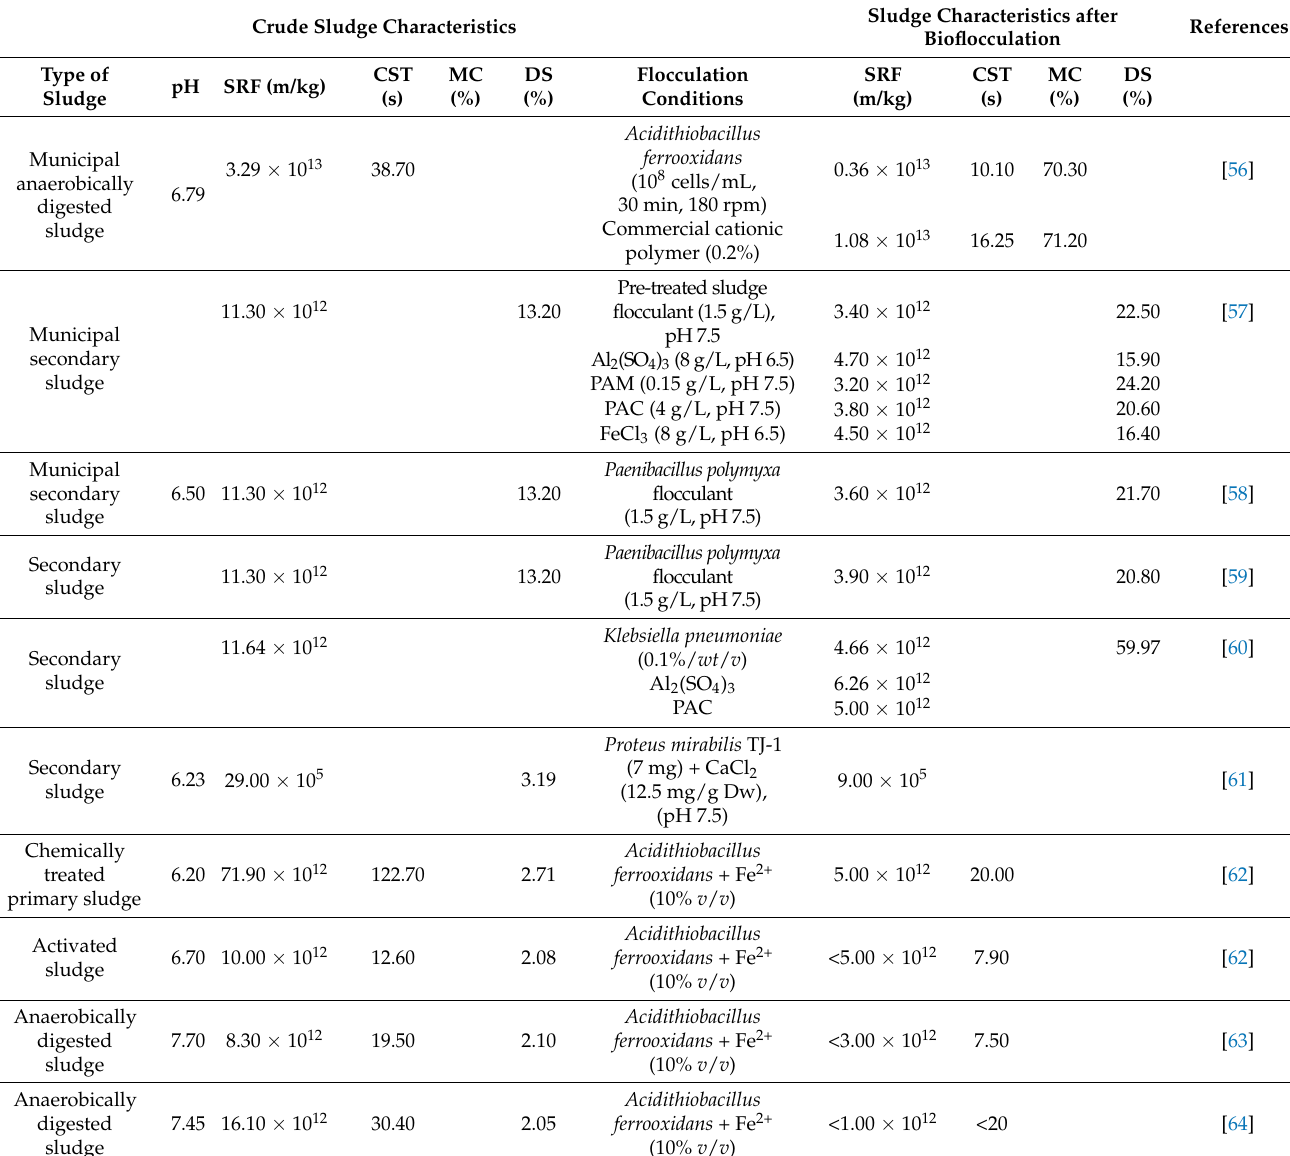
Figure 1. General process of the preparation of the microbial-based flocculants. Generally, the microbial bioflocculants have been successfully applied for the removal of various pollutants (suspended solids, chemical oxygen demand, heavy metals, dyes, etc.) with high efficiency levels (>90%), allowing a significant flocculating activity (>70%) [54,55]. Interestingly they have the potential to improve sludge dewaterability, as indicated in Table 1. Table 1. Applications of microbial-based flocculants for sludge dewatering.